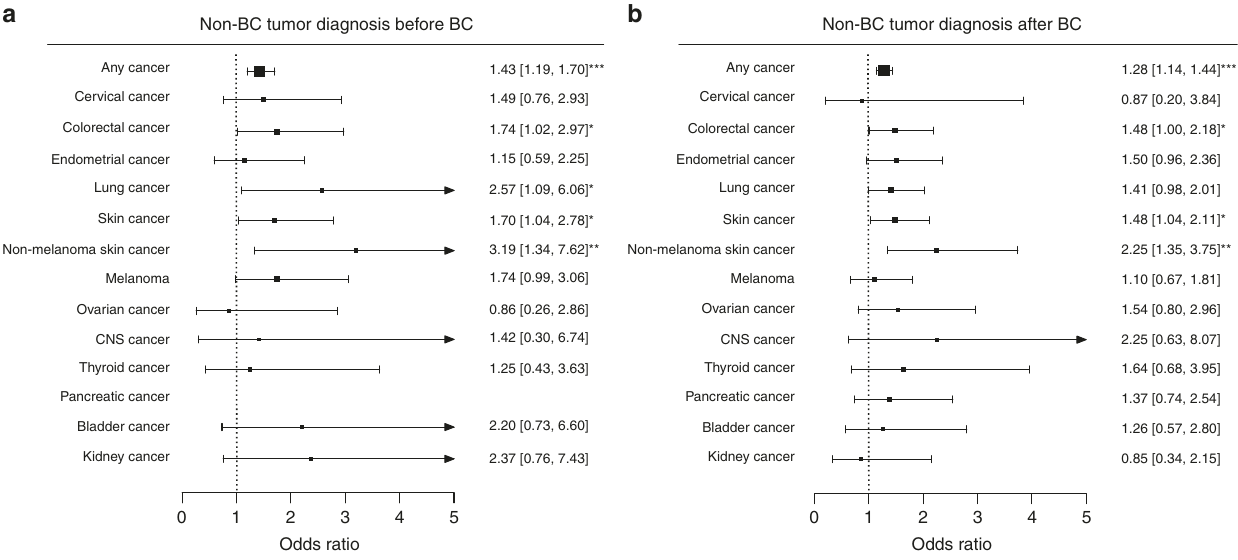
Fig. 1 Prior and subsequent non-BC tumor diagnoses in IC compared with SDC. The effect size estimates of the association with interval breast cancer (IC) risk (black squares) compared with screen-detected breast cancer (SDC) as well as the 95% con fi dence intervals (CI, horizontal lines) for different prior and subsequent cancers are shown. The exact estimates derived from logistic regression models adjusted for age at diagnosis are given on the right-hand side of the plot with the accompanying 95% CI. a A prior non-BC tumor diagnosis (any type) as well as a prior lung, skin, non-melanoma skin, or colorectal cancer diagnosis was signi fi cantly associated with increased risk for IC compared with SDC. b A non-BC tumor diagnosis after breast cancer (any type) as well as a subsequent colorectal, skin, or non-melanoma skin cancer diagnosis was signi fi cantly more common in IC cases than in SDC cases. * P < 0.05; ** P < 0.01; *** P < 0.001